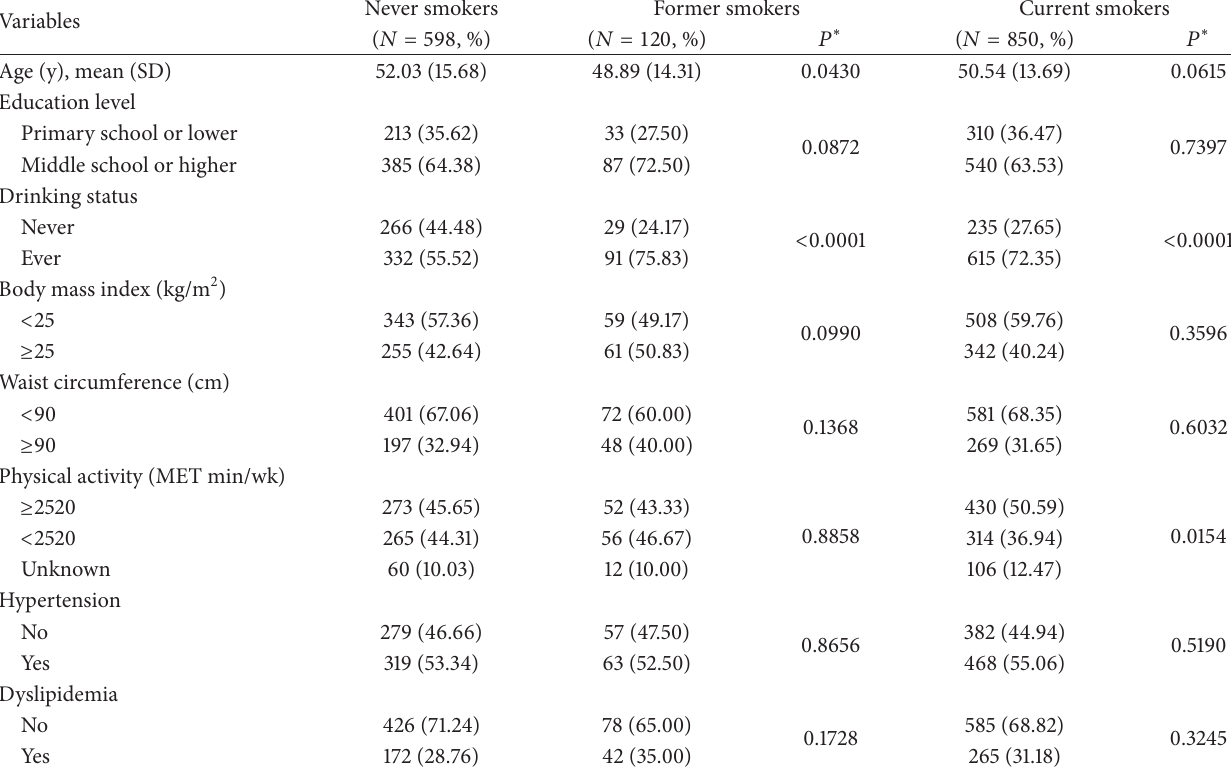
Table 1: General characteristics of study